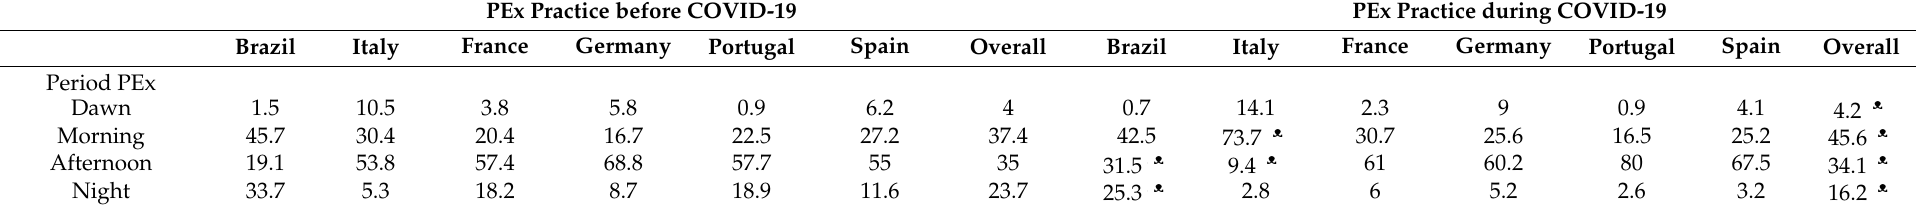
Table 1. Number of respondents per millions of people of the countries’ inhabitants.